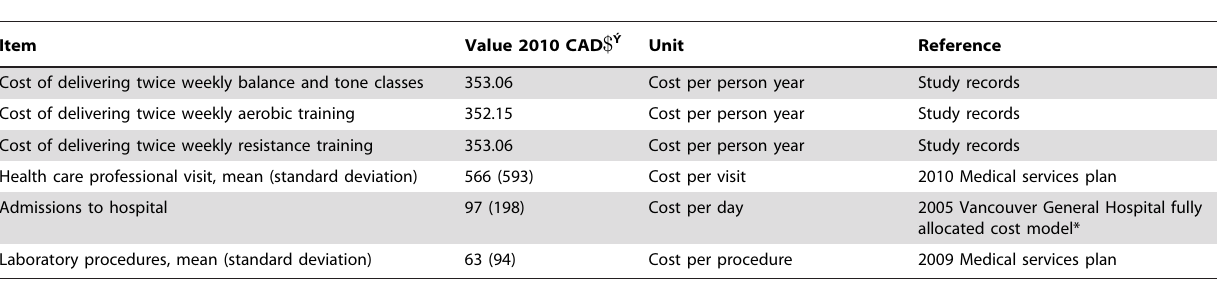
Table 2. Unit costs for each component of resource